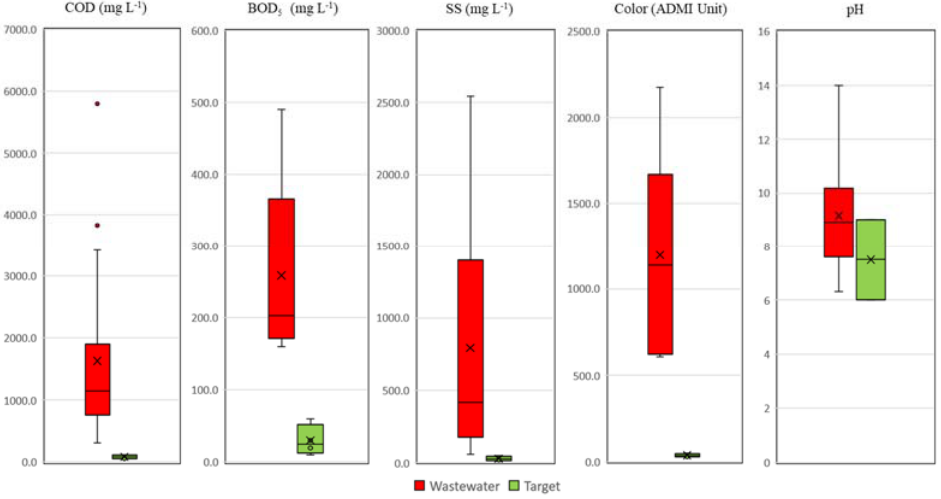
Figure 3. Gap between the pollutant concentration in raw textile wastewater and discharge standards of major pollutants.